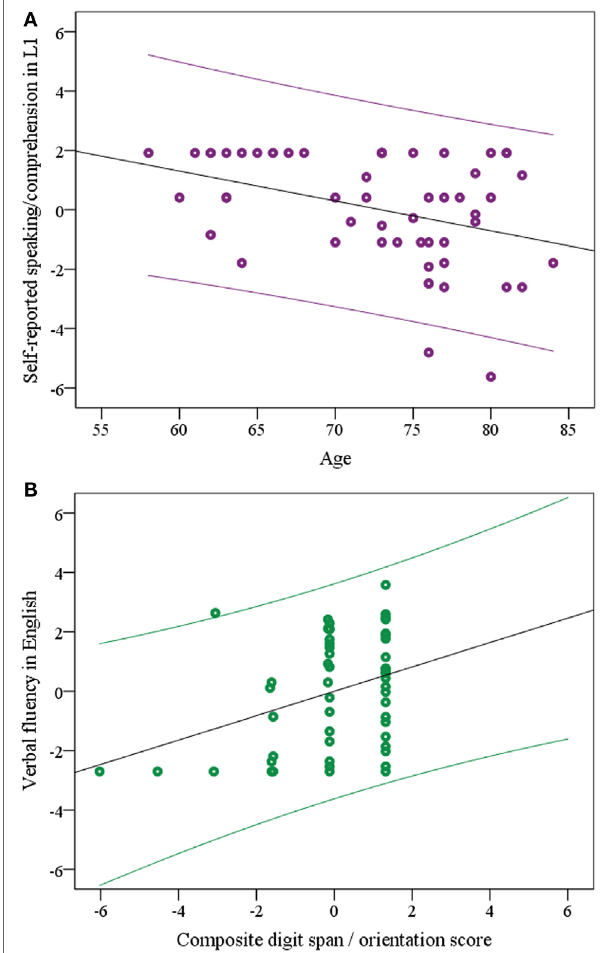
FigUre 2 | Cognitive predictors of language proficiency: age as a predictor of self-reported speaking/comprehension in L1 (a) ; composite digit span/ orientation as a predictor of verbal fluency in English (b) . Pairwise correlations are plotted with error lines representing 95% confidence